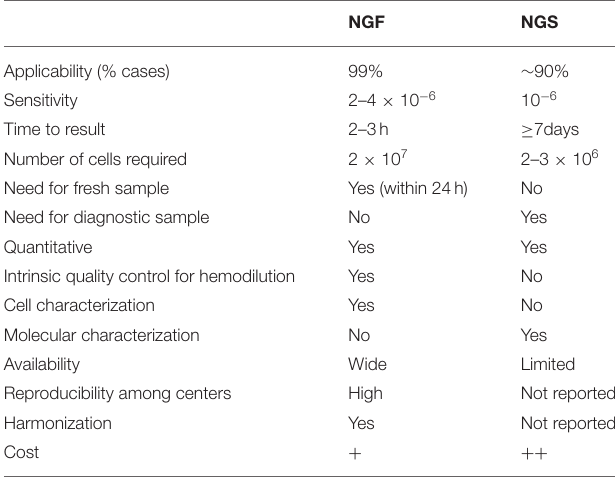
TABLE 1 | Technical features of NGF and NGS for MRD